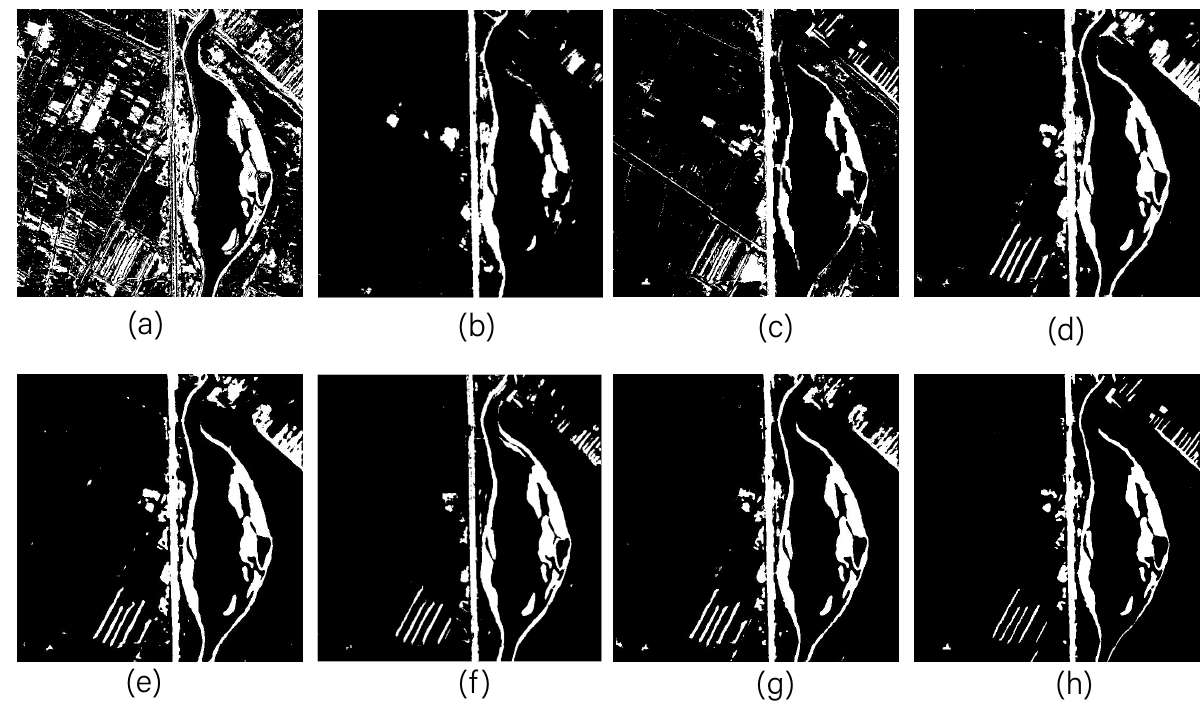
Figure 7. Binary change maps of Hongqi Canal dataset. ( a ) CVA. ( b ) IRMAD. ( c ) SCCN. ( d ) SSJLN. ( e ) STA. ( f ) DSAMNet. ( g ) SJAN. ( h ) Ground truth. The unchanged samples are black and changed samples are